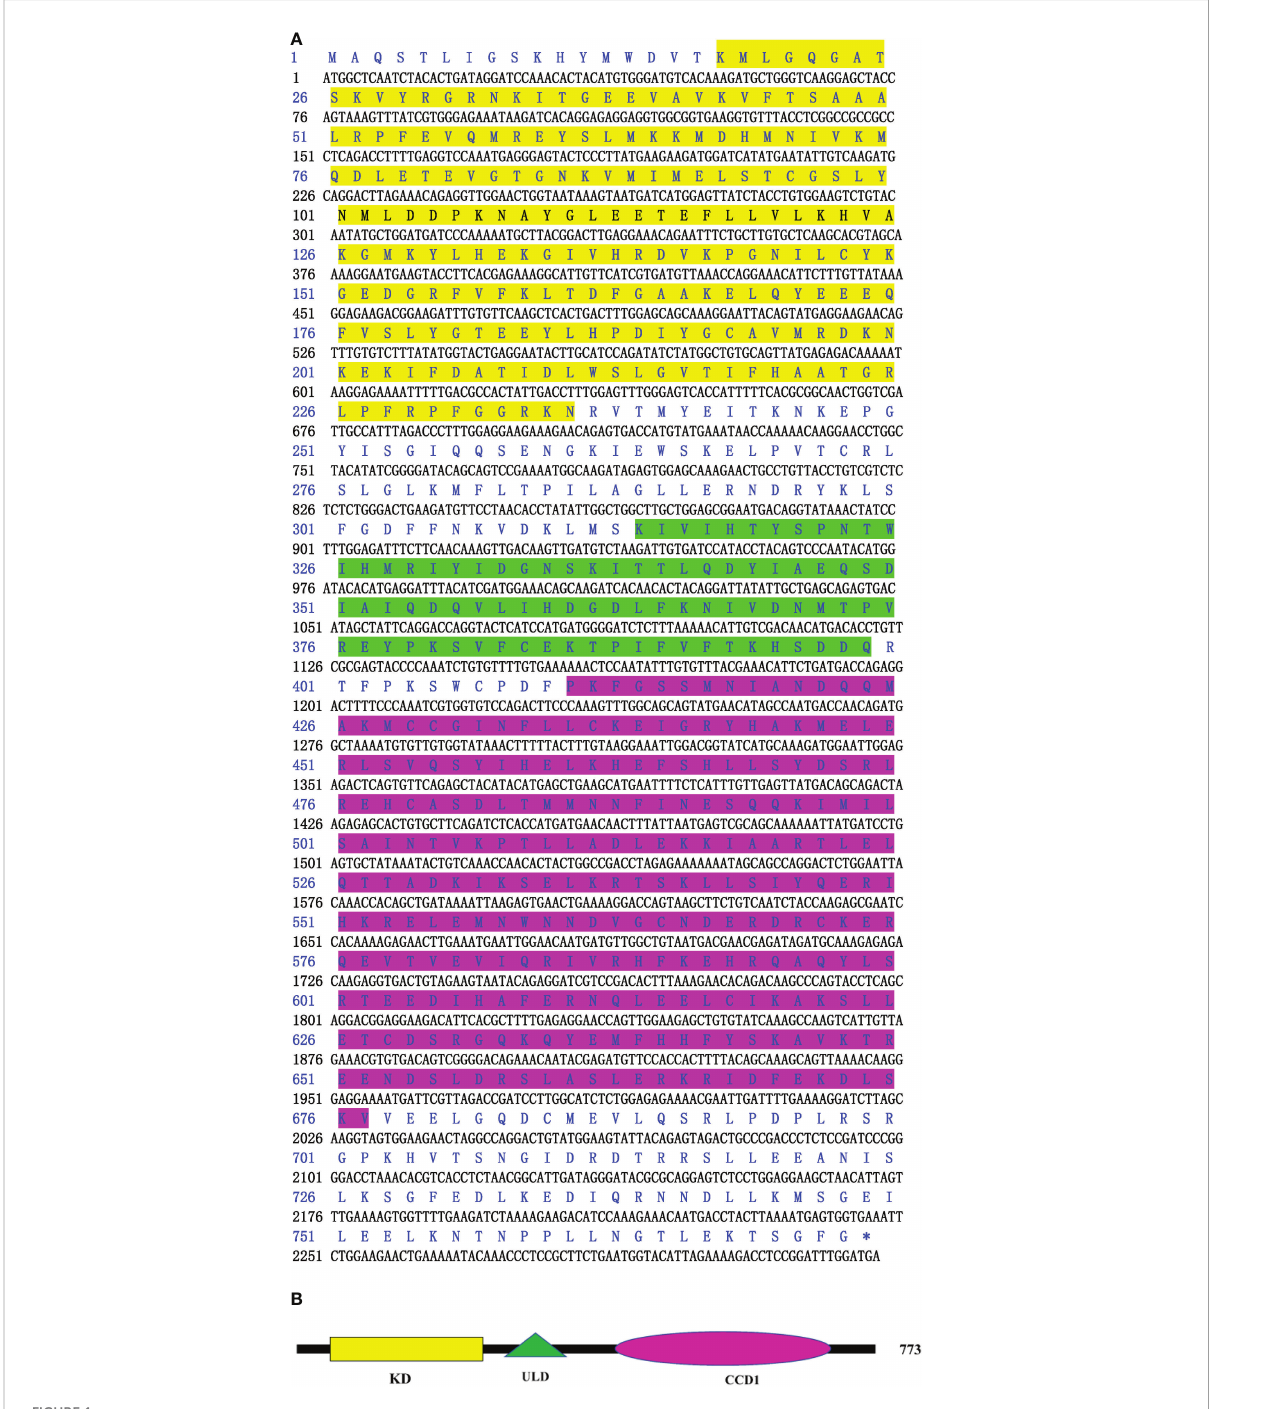
FIGURE 1 Nucleotide and deduced amino acid sequence of CfIKK3 (A) and schematic representation of CfIKK3 protein (B) . The KD (highlighted in yellow on the sequence), ULD (green highlighted), and CDD1 (fuchsia highlighted) were predicted using the NCBI Conserved Domain search program (https://www.ncbi.nlm.nih.gov/Structure/cdd/wrpsb.cgi) and Simple Modular Architecture Research Tool (SMART, http://smart.embl-heidelberg. de/). KD, kinase domain; ULD, ubiquitin-like domain; CCD1, coiled-coil domain